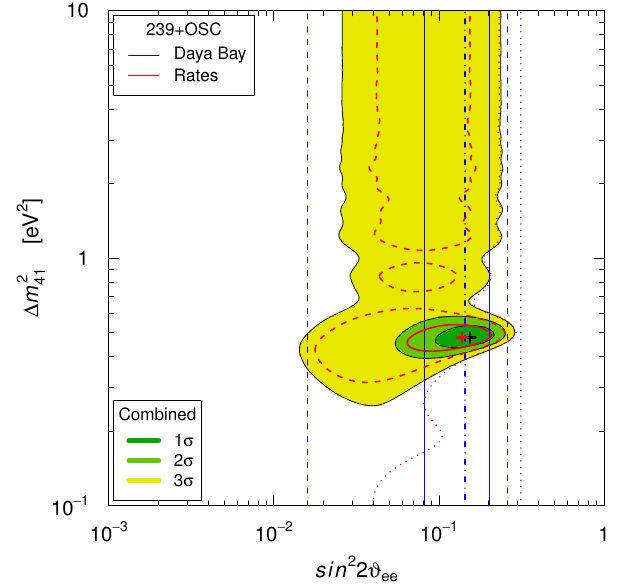
Figure 6 . Allowed regions in the sin 2 2 # ee {(cid:1) m 2 plane obtained from the (cid:12)t of the Daya Bay 41 evolution data [11] (Daya Bay), from the (cid:12)t of the reactor rates (Rates), and from the combined (cid:12)t (Combined) with the 239+OSC model. The best (cid:12)t points are indicated by crosses, except for the (cid:12)t of the Daya Bay evolution data for which the best (cid:12)t is the vertical dash-dotted line. For the Daya Bay and Rates (cid:12)ts the 1 (cid:27) , 2 (cid:27) , and 3 (cid:27) allowed regions are limited, respectively, by solid, dashed, and dotted lines.